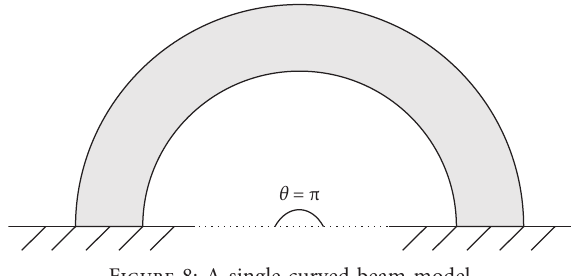
Figure 8: A single curved beam